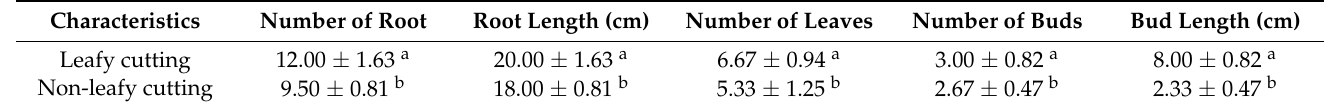
Table 2. The effect of leafy and non-leafy explants on root number, root length, leaf number, bud length, and bud number in C. indicum .